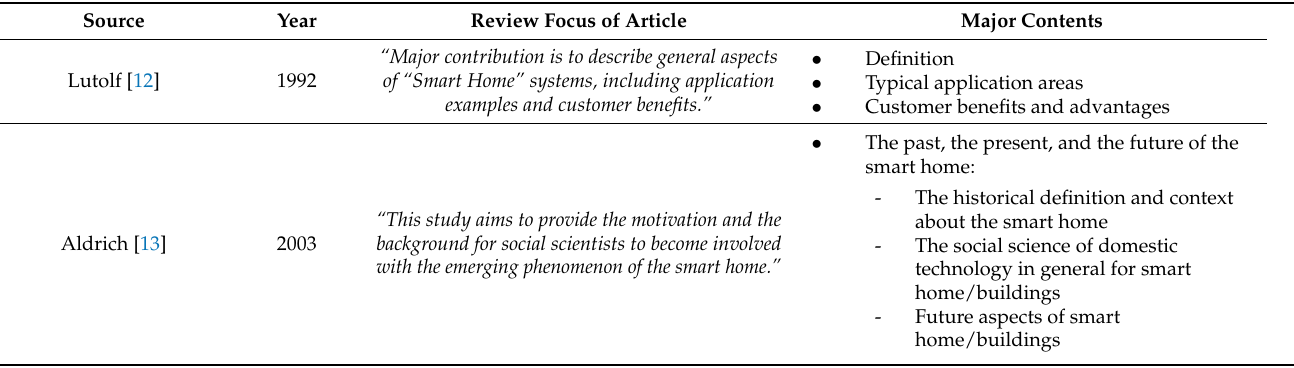
Table 2. Summary of review-type journal articles regarding smart home/building(s) and their related